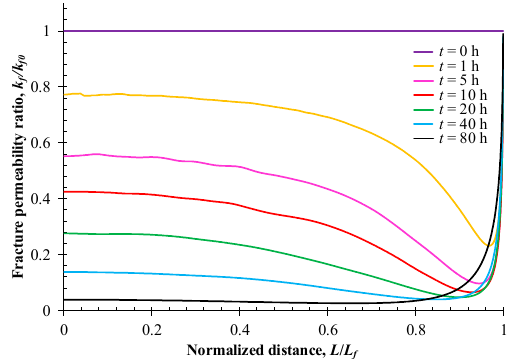
Figure 19. Distribution of permeability ratio along the fracture.